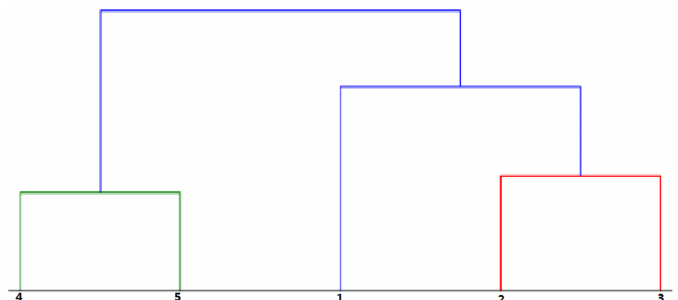
Figure 6. Result of HC applied on the curves of T d distribution for the different regions of the experiment.